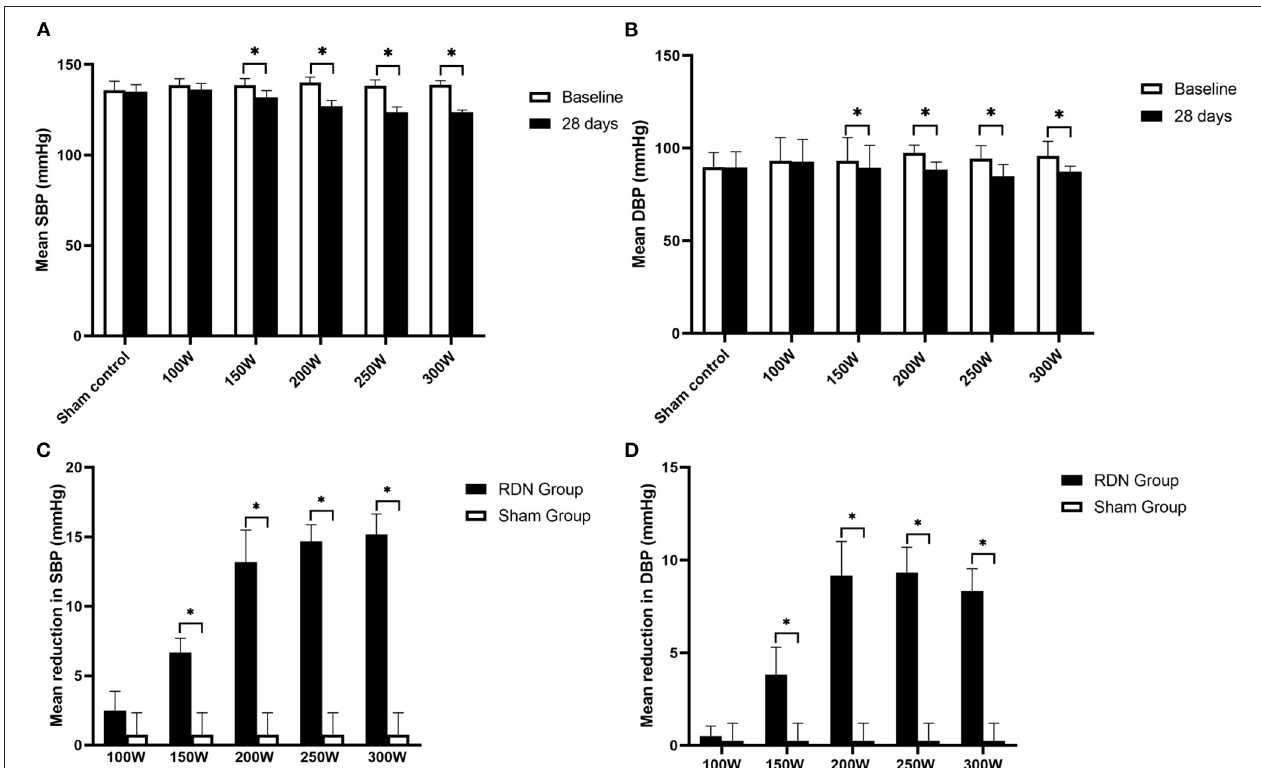
FIGURE 2 | Mean SBP, DBP at baseline and day 28 after RDN. (A, B) Comparison of mean SBP, DBP between baseline and at day 28. (C, D) Mean reduction in SBP, DBP at day 28. SBP, systolic blood pressure; DBP, diastolic blood pressure. * < 0.05.